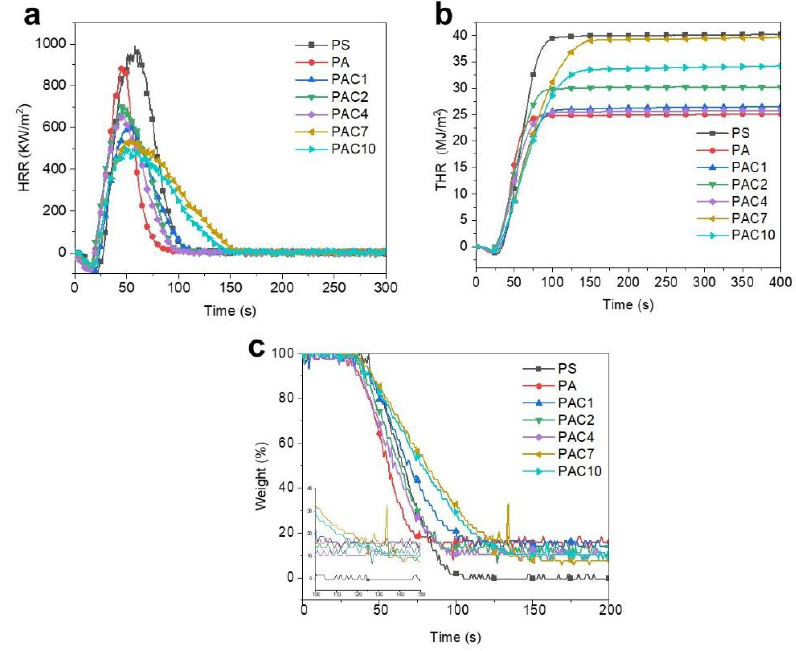
Figure 5. ( a ) HRR, ( b ) THR, and ( c ) weight loss curves of PS and its composites. PS, as a pendant aromatic group-containing polymer, will release abundant smoke and toxic substances during the combustion process, which is a risk to human health and can cause personnel casualties [40 – 42]. Therefore, it is great importance to investigate the release of smoke and toxic substances during the combustion of PS samples. The CO and CO 2 release profiles and relevant data of toxic fumes for PS and its composite are pre- sented in Figure 6 and Table 2, respectively. As shown in Figure 6a,b, the PSPR and TSR of pure PS are as high as 0.66 m 2 /s and 4354 m 2 /m 2 , respectively. As for PAC composites, the values of PSPR and TSR are obviously reduced. For example, the PSPR and TSR of the PAC10 composite are decreased to 0.36 m 2 /s and 3868 m 2 /m 2 , reduced by 45.5% and 11.2%, respectively, in comparison with those of pure PS. CO and CO 2 are the two main toxic and suffocating gases that cause casualties in fires. Thus, it is important to discuss the produc- tion of CO and CO 2 . The pure PS has a high peak of COPR (PCOPR, 0.0143 g/s) and a peak of CO 2 PR (PCO 2 PR, 0.4552 g/s), which can be observed in Figure 6c,d. Compared to the values of pure PS, both PCOPR and PCO 2 PR of the PA composites declined to 0.0137 kW/m 2 and 0.4012 MJ/m 2 , respectively. Furthermore, PAC composites show great ad- vantages in the suppression of volatile gas production. Compared with those of pure PS, the PCOPR and PCO 2 PR of the PAC10 composite are greatly decreased to 0.0083 g/s and 0.2190 g/s, respectively. The results above further demonstrate that the synergistic effect between SiAPP and aMWCNT can markedly inhibit the release of smoke and toxic gases.